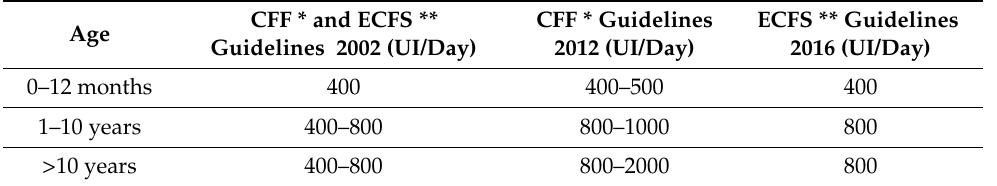
Table 1. Evolution of recommendations on routine supplementation with vitamin D in Cystic Fibrosis patients according to European and American guidelines. CFF * and ECFS ** Age Guidelines 2002